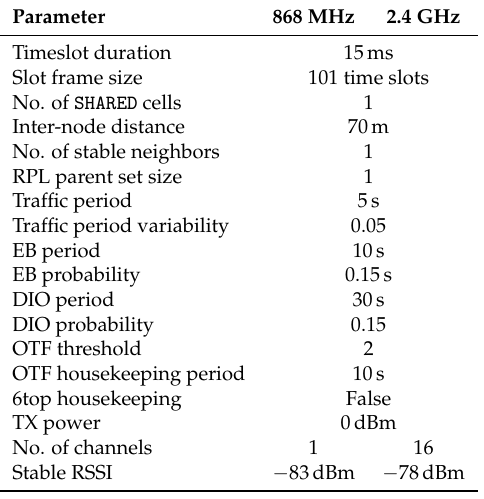
Table 18. Parameter configuration in the 6TiSCH simulator.